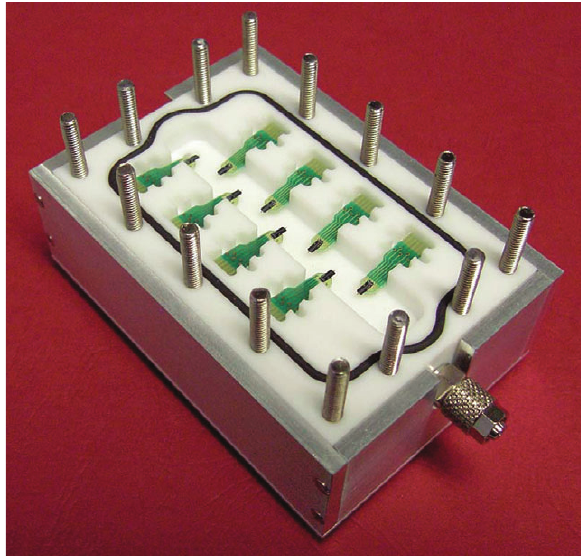
Figure 9 Teflon measurement cell holding eight MC chips appli- cable for either gas single injection or gas flow mode. Reproduced with permission from Filenko et al. (2008)